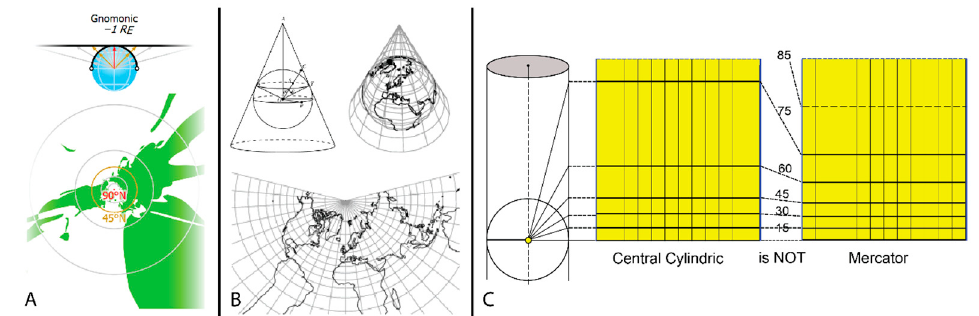
Figure 1. Examples for educational resources following the light source metaphor when explaining map projections: ( A ) gnomonic azimuthal projection ( https://commons.wikimedia.org/wiki/File:Comparison_azimuthal_projections.svg, CC BY-SA 3.0, accessed 15.02.2019); ( B ) central conic projection (Weisstein, Eric W. “Conic Projection.” From MathWorld—A Wolfram Web Resource. http://mathworld.wolfram.com/ConicProjection.html, © 1999–2019 Wolfram Research, Inc., accessed 15.03.2019); ( C ) central cylindrical projection and Mercator projection (https://commons.wikimedia.org/wiki/File:Mercator_and_central_cylindrical.png, Public Domain, accessed 15.02.2019).